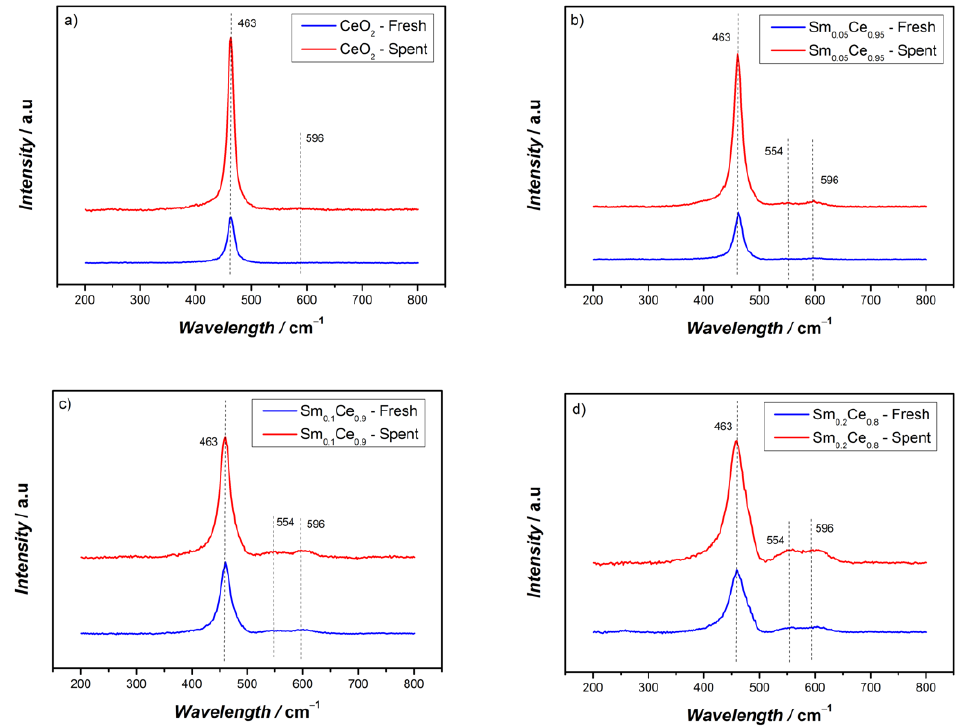
Table 2. Ce 3+ percentages and O  percentages of fresh and spent catalysts.